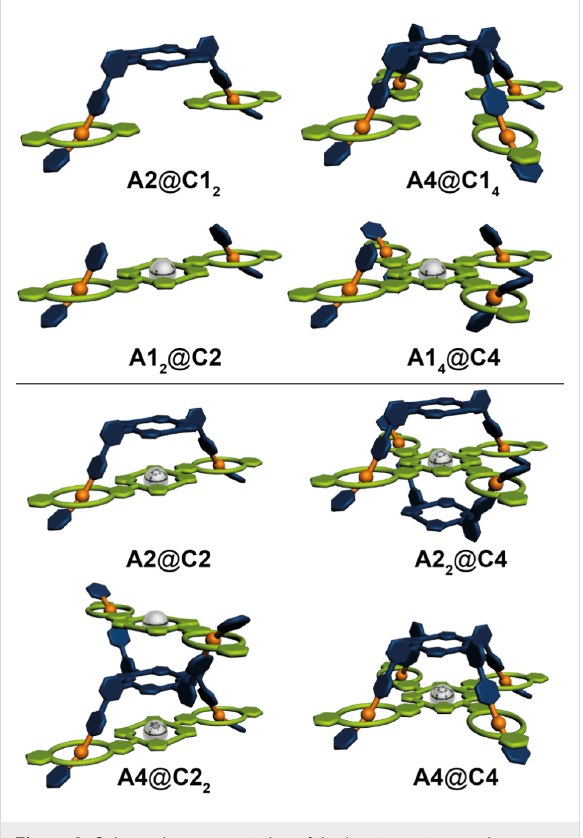
Figure 2: Schematic representation of the host–guests complexes. Top: complexes A2 @ C1 2 , A4 @ C1 4 , A1 2 @ C2 and A1 4 @ C4 , which are built from one multi- and several monovalent building blocks. Bottom: complexes A2 @ C2, A2 2 @ C4, A4 @ C2 2 and A4 @ C4 , which are built from di- or tetravalent building